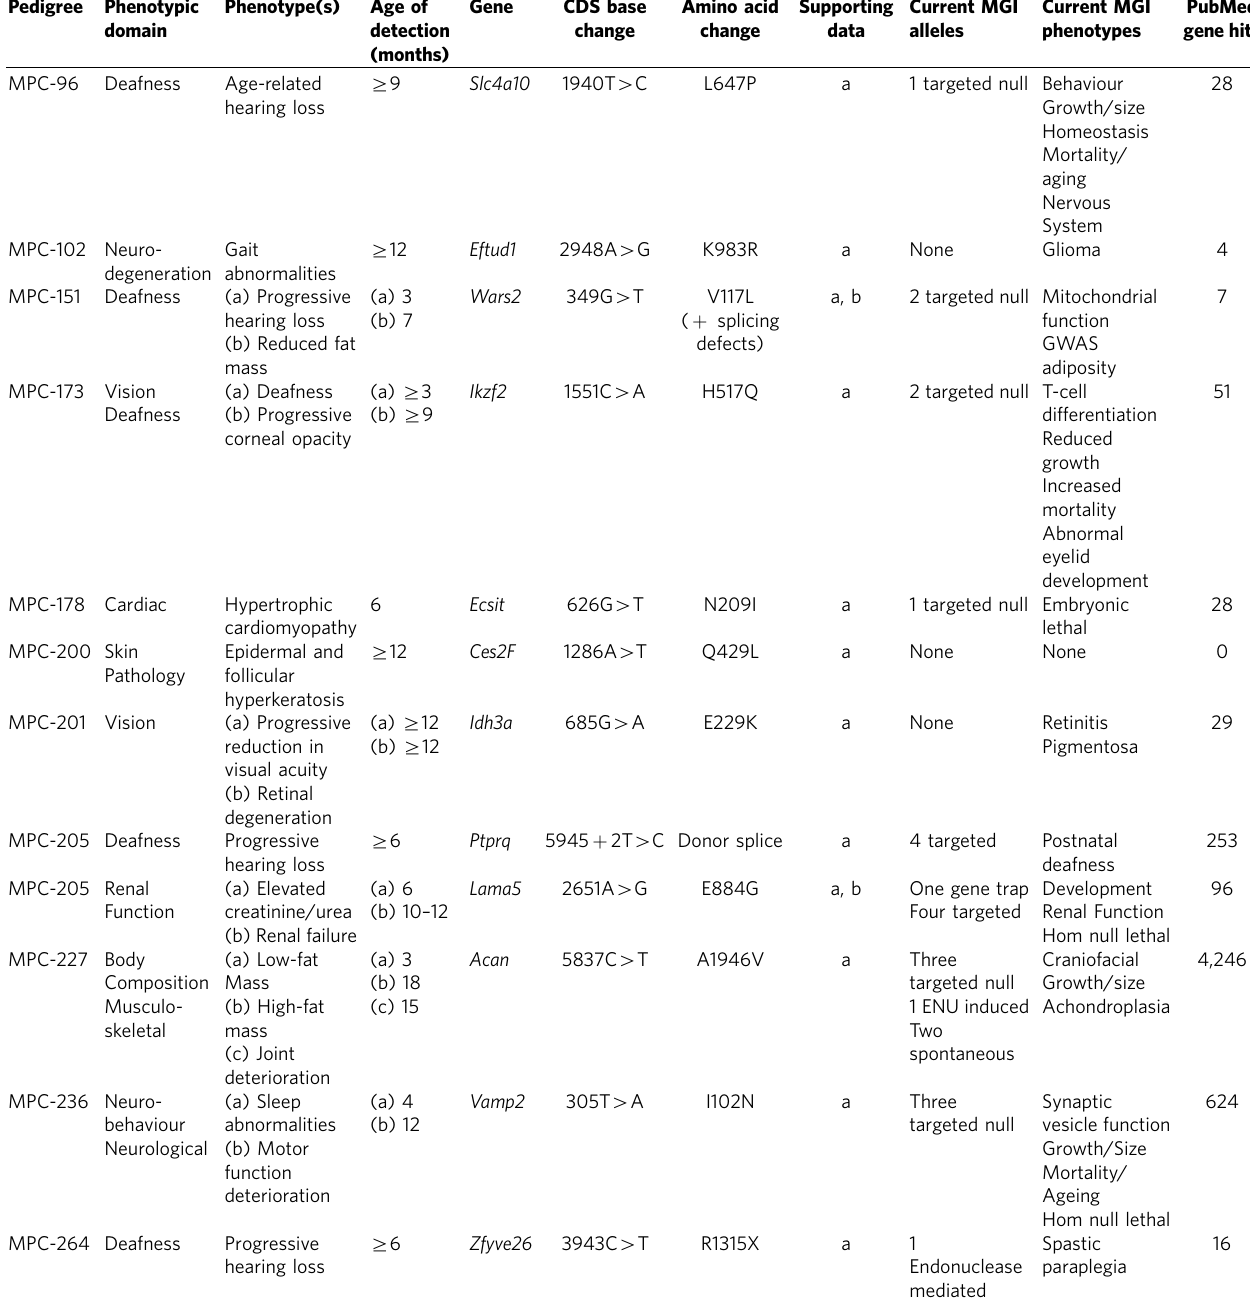
Table 3 | Examples of phenotypes and mutations identified as part of the Harwell Ageing Screen. Pedigree Phenotypic